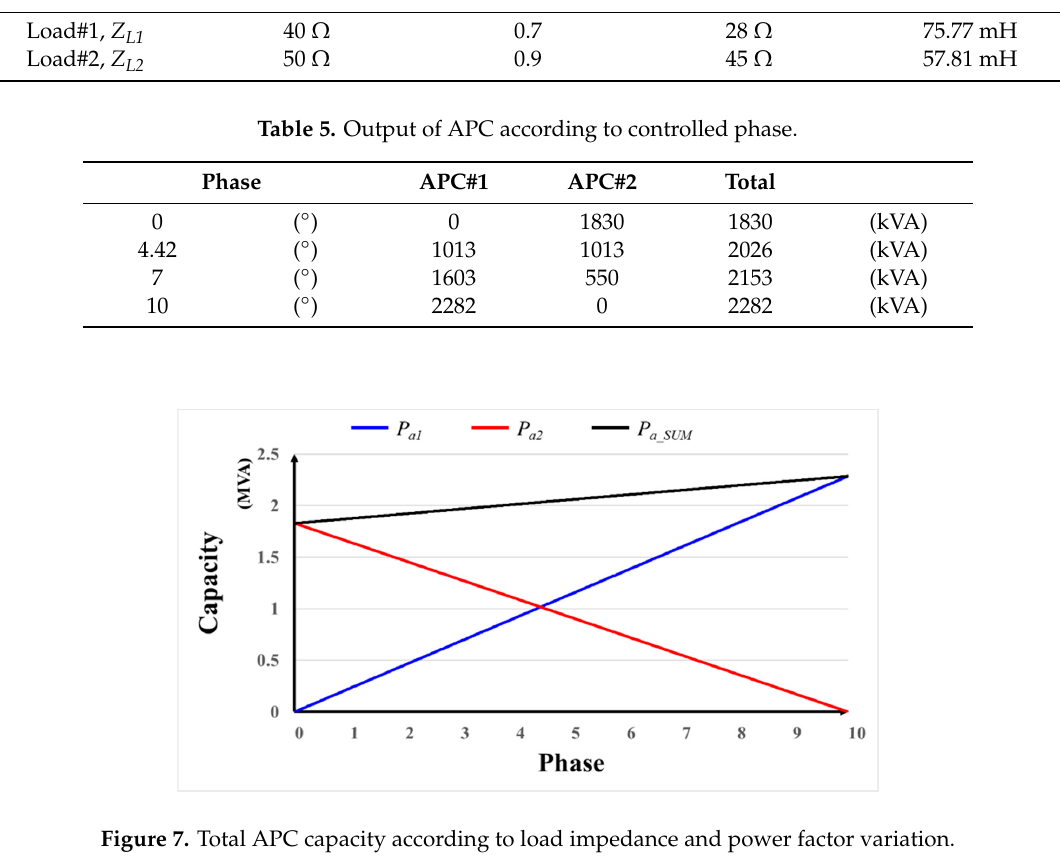
Table 4. Distribution Line Parameters.